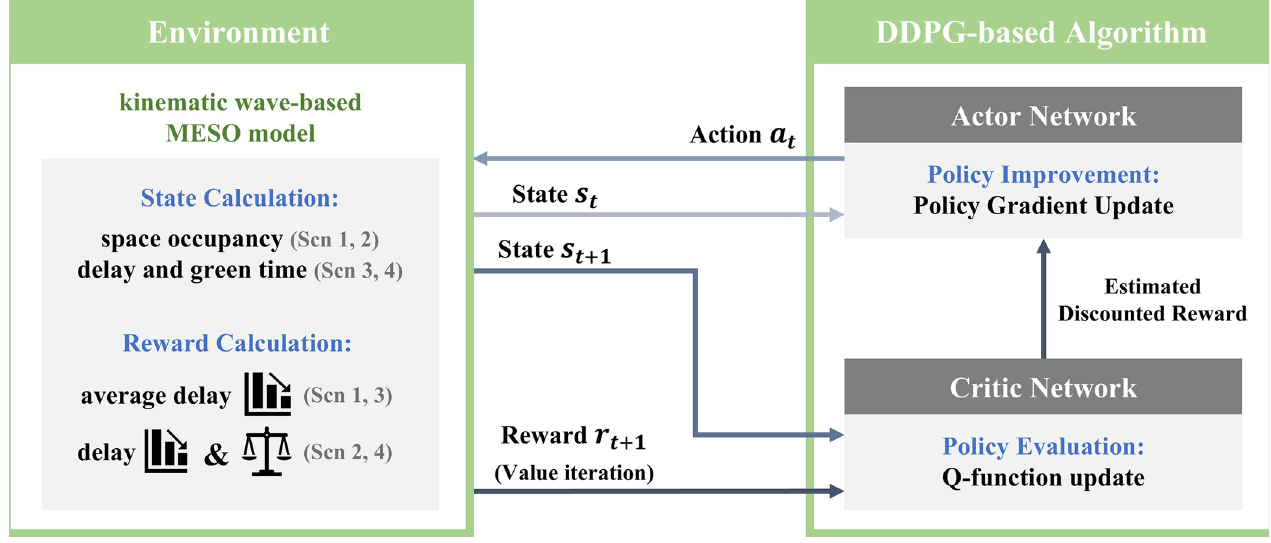
Fig 1. Framework of the proposed signal control